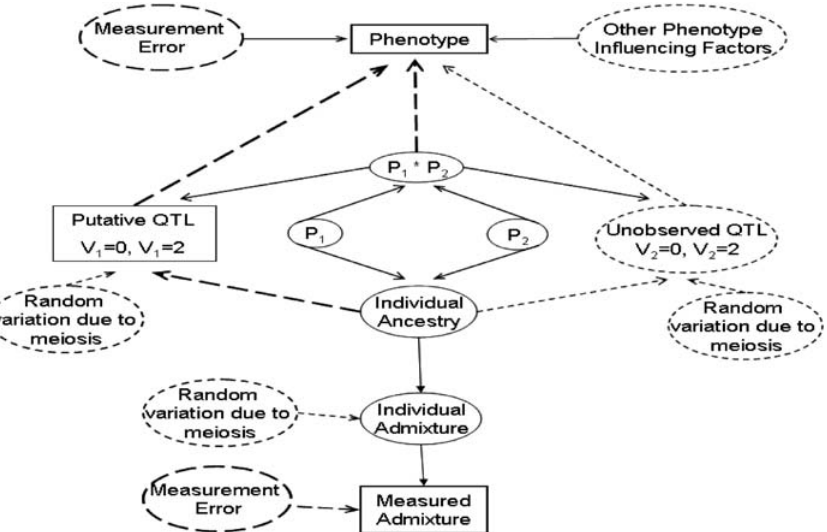
Figure 1. Path Diagram Illustrating the Relationship between Admixture, Ancestry, and Phenotype This figure was created based on the rules of path diagrams outlined in [65] with minor modifications. We wish to explore the association of the putative QTL with a given phenotype. However, as illustrated, this zero-order (i.e., unadjusted) association may be affected by relationships with other factors. The rectangles and ellipses in the path diagram represent observable and latent (unobservable) variables, respectively. The dashed ellipses indicate variables potentially capable of influencing the phenotype. Sources of error from random variation introduced by the meiosis process or measurement error are indicated for observable and unobservable variables. The variable v i , i ¼ 1,2 denotes the number of alleles inherited from a specific parental population at the i th QTL (the putative QTL, QTL 1, is observed, whereas QTL 2 is unobserved). Note that for a specific QTL, only two possible values of V i , i ¼ 1,2 are considered in the model; the third possible value will serve as a reference. P i , i ¼ 1,2 represents the ancestry of each parent for a sampled individual. The objective is to test for association between the putative QTL and the observed phenotype. Observed association may simply result from unaccounted correlation among the putative QTL, the phenotype, and individual ancestry. The association can be further confounded by the presence of unobserved factors, such as QTL 2. Controlling for parental and individual ancestry would break this confounding pathway. Because ancestry is not directly observable, individual admixture estimates are used as surrogates. These estimates, obtainable through existing software, can be seen as error-contaminated measurements of the true individual ancestry values. Hence, the measurement error problem must be addressed when including these estimates in the model. Hoggart et al. [7] offer a figure similar to the one presented here. DOI: